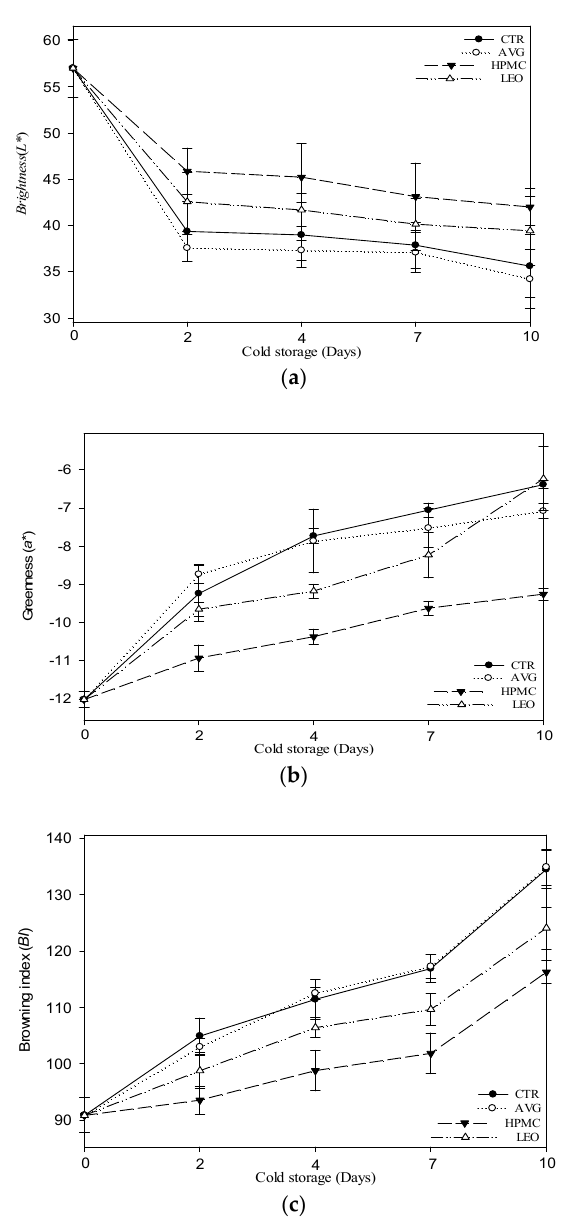
Figure 1. ( a – c ) Brightness ( L* ), greenness ( a* ) and browning index ( BI ) of kiwifruit slices treated with AVG, HPMC and LEO coatings and not treated (CTR) at day 0 and after 2, 4, 7 and 10 days of cold storage at 4 ± 1 °C and 90% ± 5% relative humidity (RH) in dark conditions. Values indicate the means, and the bars indicate the standard deviations of the replicates ( n = 3). Abbreviations: CTR, uncoated fruit slices, AVG, fruit slices coated with 40% v / w of Aloe vera gel only, HPMC, fruit slices coated with 40% v / w of Aloe vera gel + 0.1% v / w of hydroxypropyl methylcellulose and LEO, fruit slices coated with 40% v / w of Aloe vera gel + 0.1% v / w of lemon essential